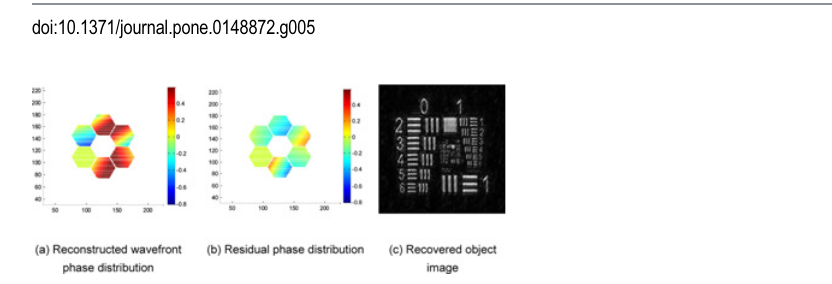
Fig 5. Experimental results of the resolution test panel with alignment correction.